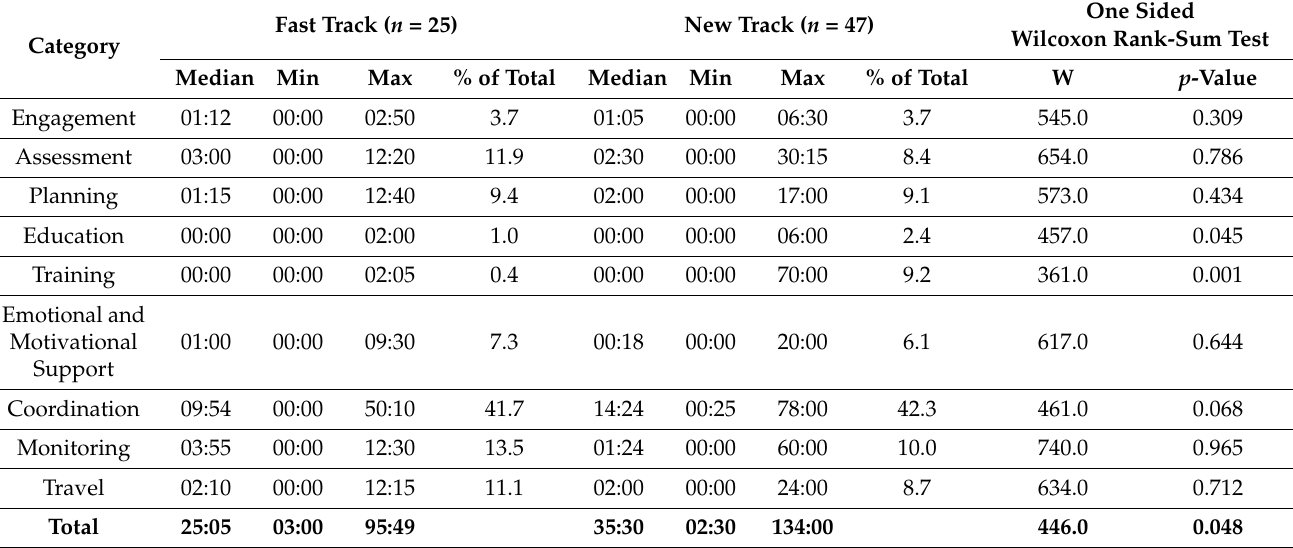
Table 4. Service actions by